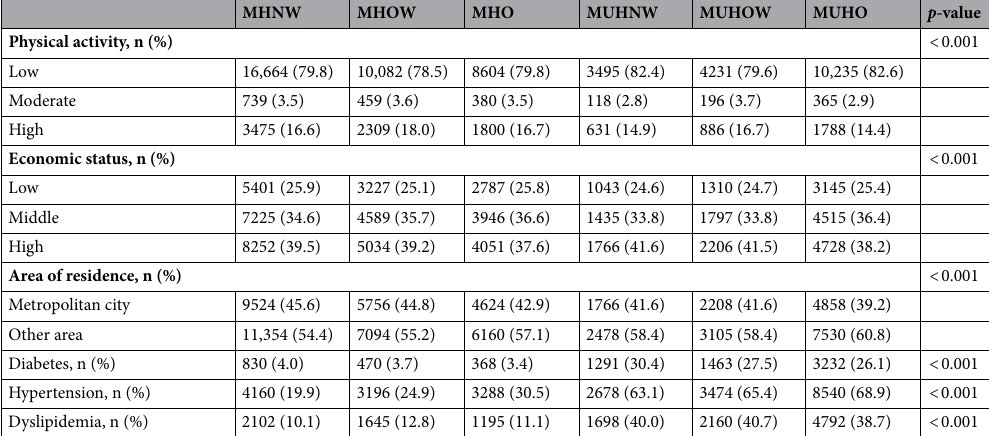
Table 1. Baseline characteristics of study participants according to metabolic healthy and obesity. Values are presented as n (%) or mean ± standard deviation. MHNW metabolically healthy normal weight, MHOW metabolically healthy overweight, MHO metabolically healthy obese, MUHNW metabolically unhealthy normal weight, MUHOW metabolically unhealthy overweight, MUHO metabolically unhealthy obese, HDL high-density lipoprotein, LDL low-density lipoprotein, ALT alanine aminotransferase, GGT gamma-glutamyl transferase.